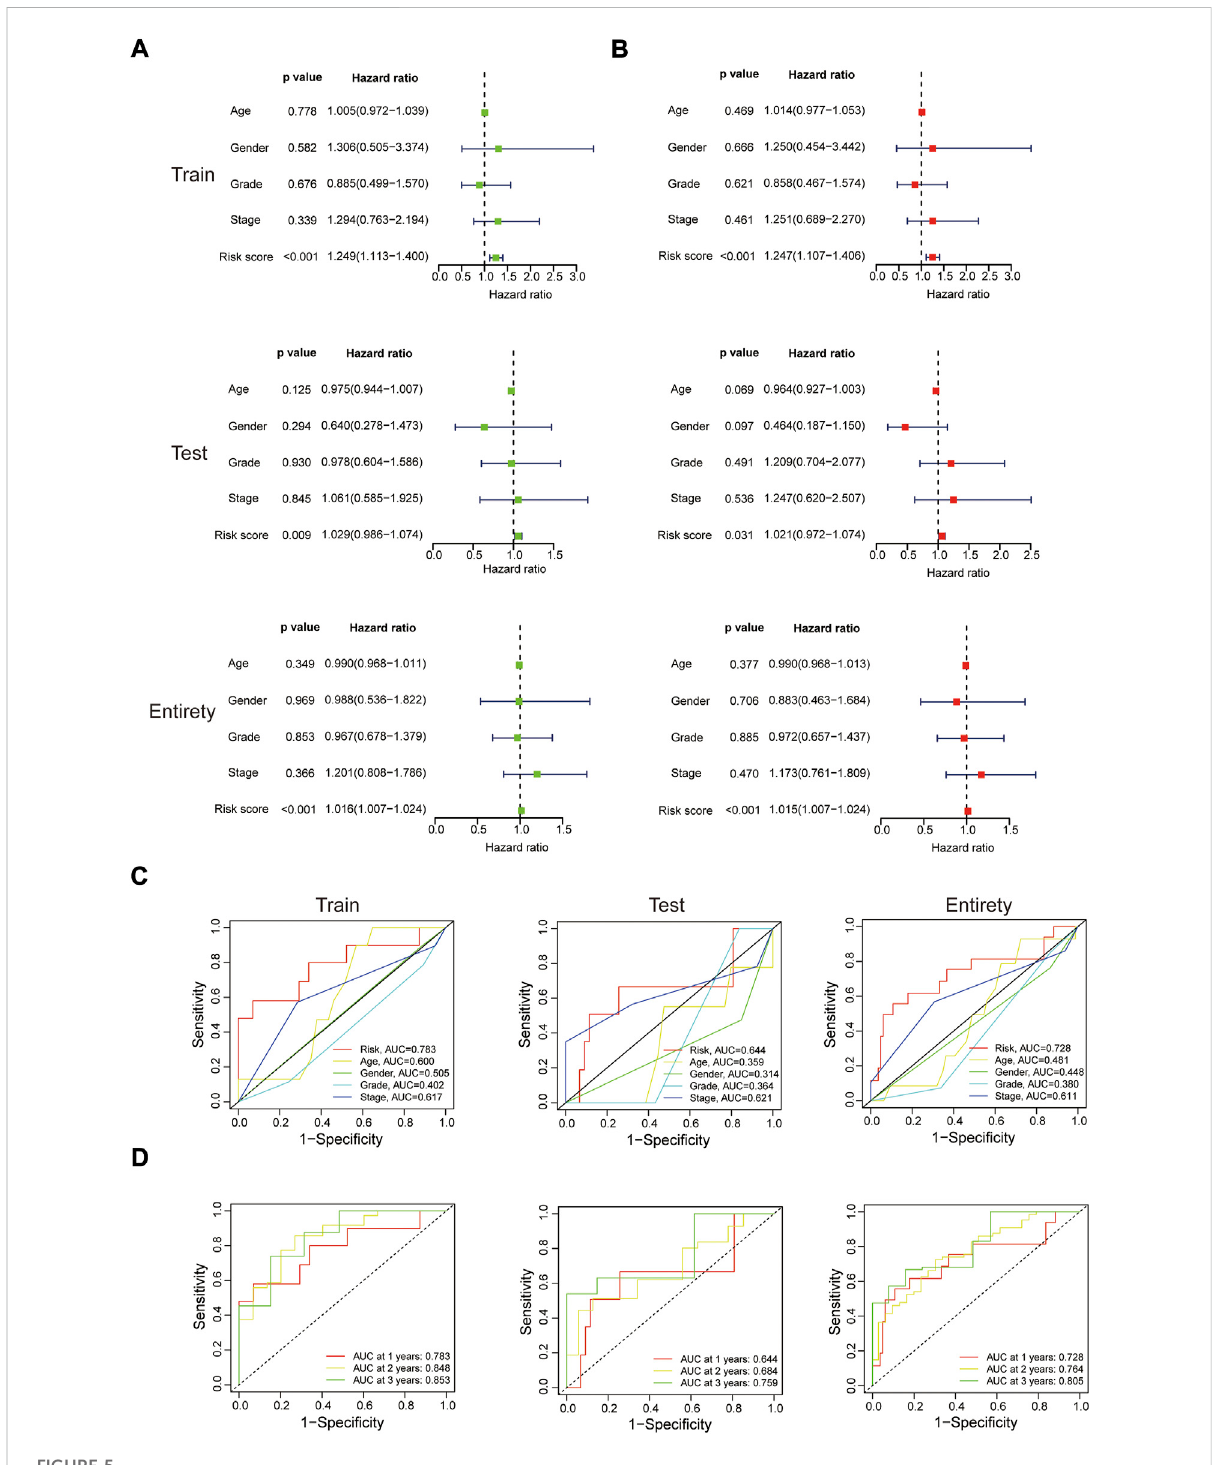
FIGURE 5 In-depth assessment of the protein prognostic risk model. (A,B) Univariate and multivariate Cox regression analyses of clinical features and the risk model with overall survival in the three sets. ROC analysis for 1 year survival rate of the risk model, age, gender, grade and stage (C) , and the risk model at 1-, 2-, 3-year survival time (D)